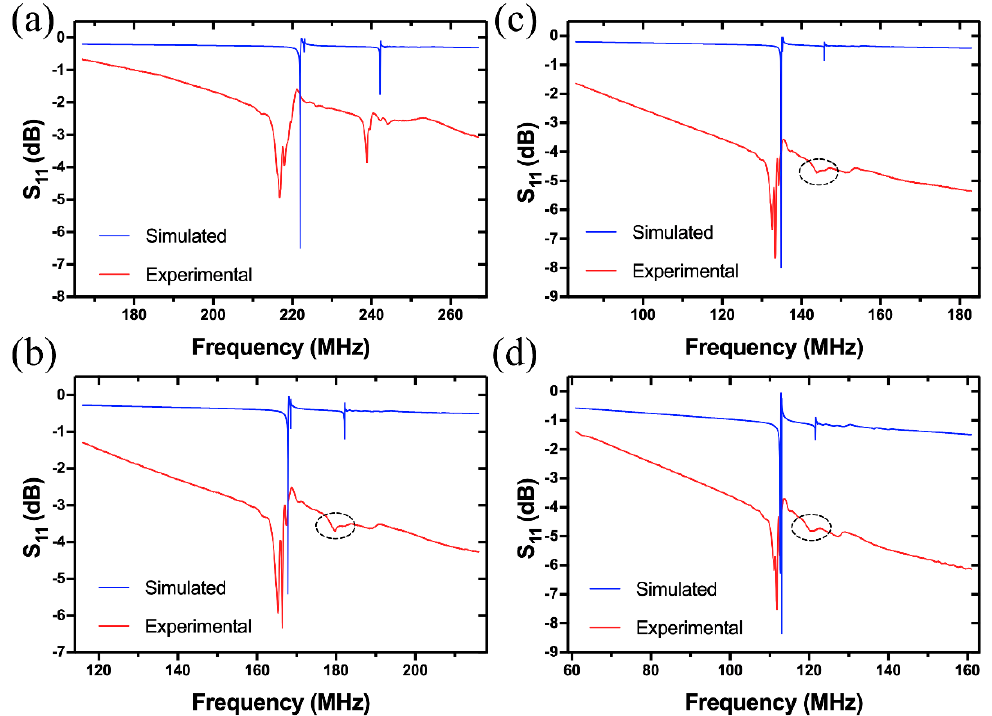
Figure 6. Comparison of the simulated and experimental reflection spectra of Device A when 𝜆 is 12 μm ( a ), 16 μm ( b ), 20 μm ( c ) and 24 μm ( d ). 12 µ m ( a ), 16 µ m ( b ), 20 µ m ( c ) and 24 µ m ( d